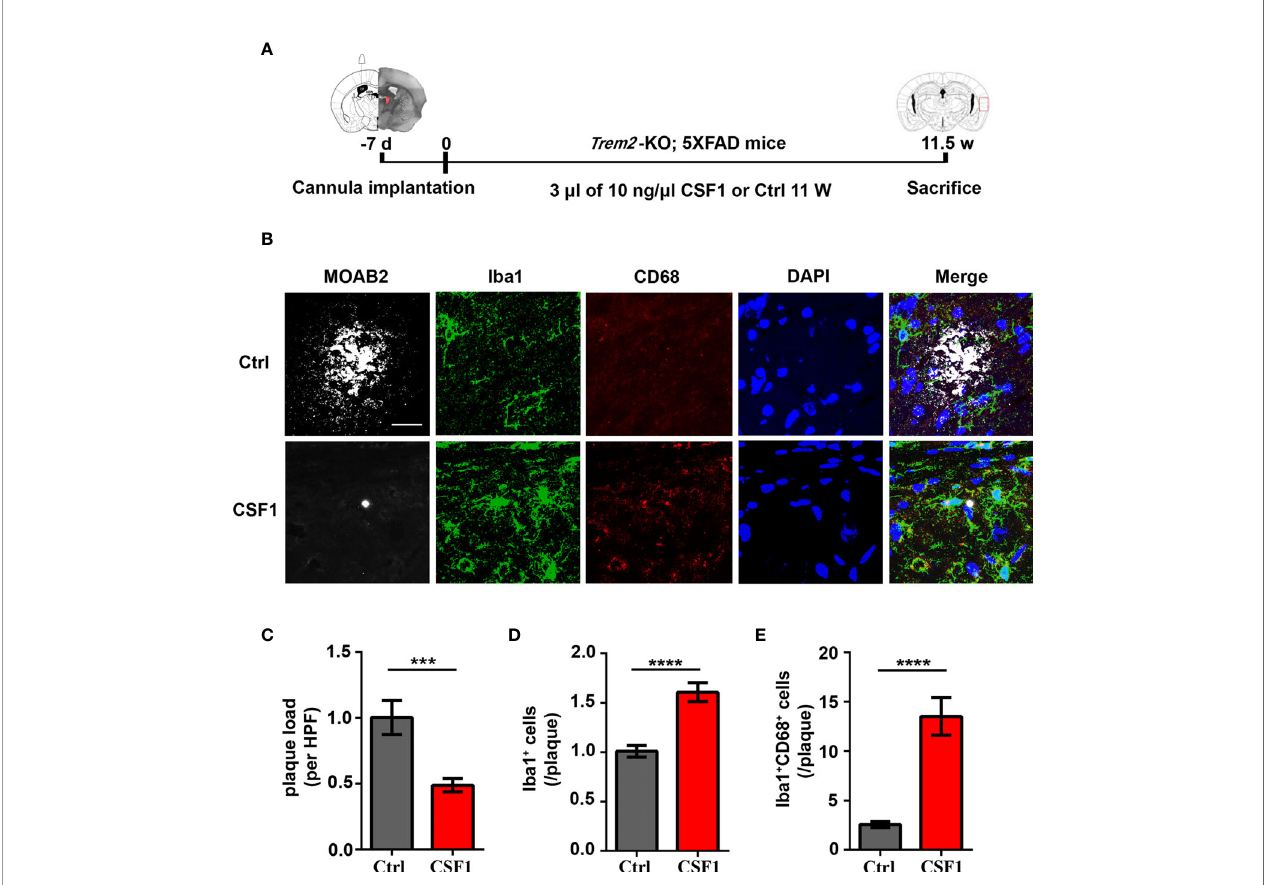
FIGURE 7 | CSF1 administration ameliorates A b plaques accumulation in Trem2 -/- ; 5XFAD mouse brain. (A) Schematic timeline of CSF1 administration in Trem2 -/- ; 5XFAD mouse brain. Trem2 -/- ;5XFAD mice were treated with 30 ng CSF1 or arti fi cial cerebrospinal fl uid-treated controls weekly for 2.5 months. The right hemispheres of the brains were embedded for cryostat sectioning and immuno fl uorescence. (B) Coronal sections of the brains were stained with Iba-1 (green) for microglia, CD68 (red) for phagocytic marker and MOAB2 (gray) for A b plaques. Representative images of microglial immuno fl uorescent staining are shown. (C) Immuno fl uorescence density of A b plaques stained with MOAB2 (gray) was quanti fi ed per HPF. A b plaques immuno fl uorescence density response to CSF1 was assessed by quantifying the plaques ratio of CSF1 group to control group in Trem2 -/- ;5XFAD mouse brain. (D) Number of microglia double stained with DAPI (blue) and Iba1 (green) was quanti fi ed per HPF. Microglia number response to CSF1 was assessed by quantifying the cell number ratio of CSF1 group to control group in Trem2 -/- ;5XFAD mouse brain. (E) Number of microglia double stained with CD68 (red) and Iba1 (green) associated with plaques was quanti fi ed per HPF. Phagocytic microglia number response to CSF1 was assessed by quantifying the co-staining cell number ratio of CSF1 group to those of control group in Trem2 -/- ;5XFAD mouse brain. Student t test. Data are plotted as mean ± SEM (n=3). *** p <0.001; **** p <0.0001. Scale bar, 50